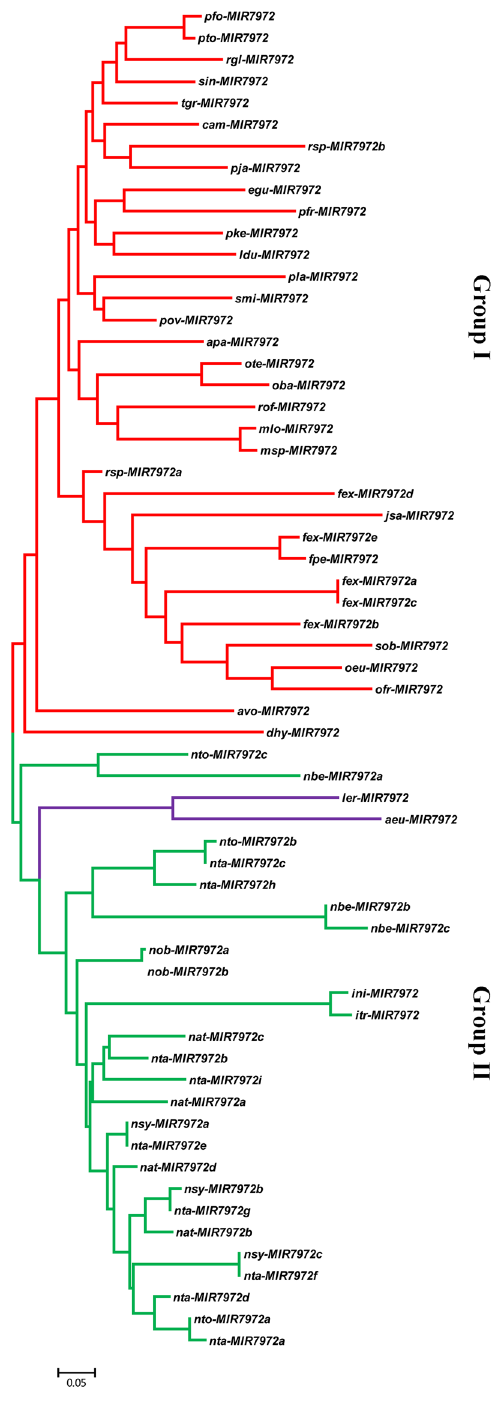
Figure 8. Phylogenetic relationships of MIR7972 precursors in various Lamiids species. It includes Ruellia speciosa (rsp), Mentha longifolia (mlo), Ocimum tenuiflorum (ote), Fraxinus excelsior (fex), Dorcoceras hygrometricum (dhy), Sesamum indicum (sin), Erythranthe guttata (egu), Nicotiana obtusifolia (nob), Ipomoea nil (ini), Ipomoea trifida (itr), Nicotiana attenuata (nat), Nicotiana sylvestris (nsy), Nicotiana tomentosiformis (nto), Nicotiana tabacum (nta), Nicotiana benthamiana (nbe), Andrographis paniculata (apa), Jasminum sambac (jsa), Syringa oblata (sob), Fraxinus pennsylvanica (fpe), Olea europaea (oeu) , Osmanthus fragrans (ofr) , Alectra vogelii (avo) , Rehmannia glutinosa (rgl) , Phtheirospermum japonicum (pja) , Pedicularis keiskei (pke) , Conopholis americana (cam) , Paulownia fortunei (pfo) , Paulownia tomentosa (pto) , Plantago ovata (pov) , Plantago lagopus (pla) , Lippia dulcis (ldu) , Tectona grandis (tgr) , Ocimum basilicum (oba) , Perilla frutescens (pfr) , Rosmarinus officinalis (rof) , Mentha spicata (msp) , Lithospermum erythrorhizon (ler) , Arnebia euchroma (aeu) . Species from Lamiales, Solanales and Boraginales are shown red, green and purple, respectively. MIR7972s could be divided into two groups, including group I and group II. The branch length is